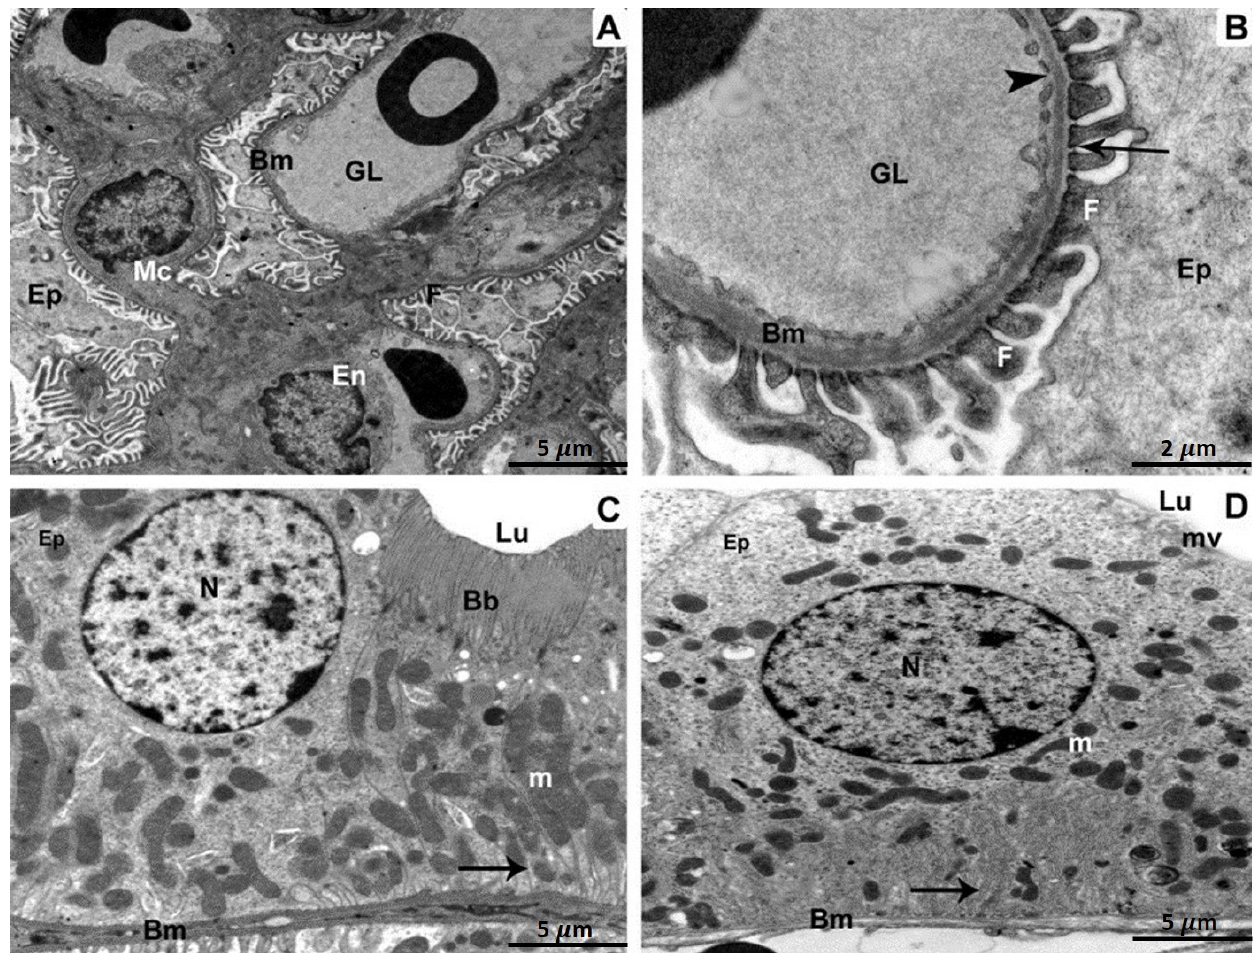
Figure 2. Kidney specimens of the control group are depicted in TEM as follows: ( A ) A glomerulus with glomerular capillaries (GL), basement membranes (Bm), endothelium (En), mesangial cells (Mc), podocytes (Ep), as well as foot processes (F). 5 µm scale bar; ( B ) A more in-depth view of the glomerular basement membrane (Bm) revealing its three distinct layers: lamina rara interna, rara externa, and densa. Foot processes (F), fenestration (arrow heads), thin diaphragms (arrows), as well as podocytes (Ep) are all illustrated (Ep). At 2 µm scale bar, section ( C ) of a proximal convoluted tubule reveals cuboidal epithelial cells (Ep) resting on the basement membrane (Bm) and the tubular lumen brush border (Lu) (Bb). The nucleus (N), mitochondria (m), in addition to infolding membranes are all distinguished characteristics (arrow). 5 µm scale bar; ( D ) A section through a distal convoluted tubule revealing cuboidal epithelial cells (Ep) resting on a basement membrane and displaying short microvilli (mv) (Bm). The infolding membranes, the nucleus, and the mitochondria are all prominent characteristics (arrow). 5 µm scale bar.